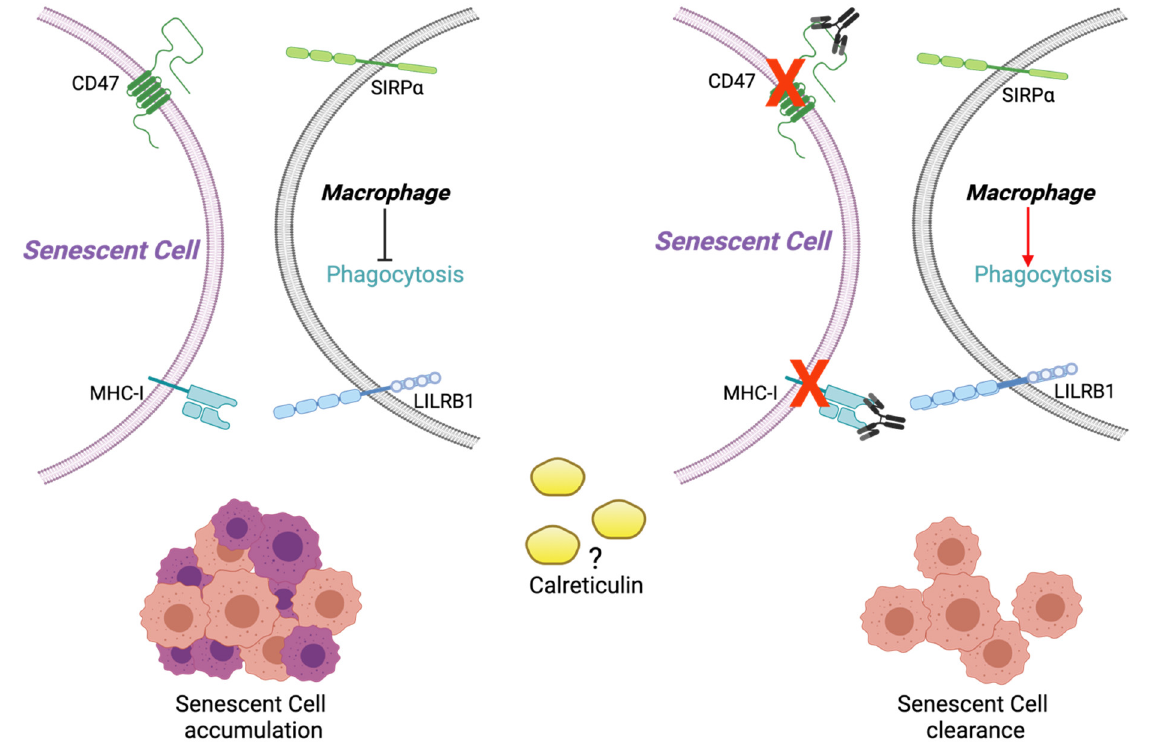
Figure 6. SC cells show increased CD47 and MHC class I (MHC-I) signals that mediate the “do not eat-me” antiphagocytic signals when they bind to their SIRP alpha and LILRB1 receptors, respectively. This mechanism might allow the accumula- tion of SC in tissues generating increased dysfunction. The use of monoclonal antibodies directed against CD47 and MHC-I could facilitate the elimination of SC. Moreover, the prophagocytic signals of Calreticulin should be further evaluated to investigate their possible participation in accumulating or eliminating SC in the tissues. Figure created with